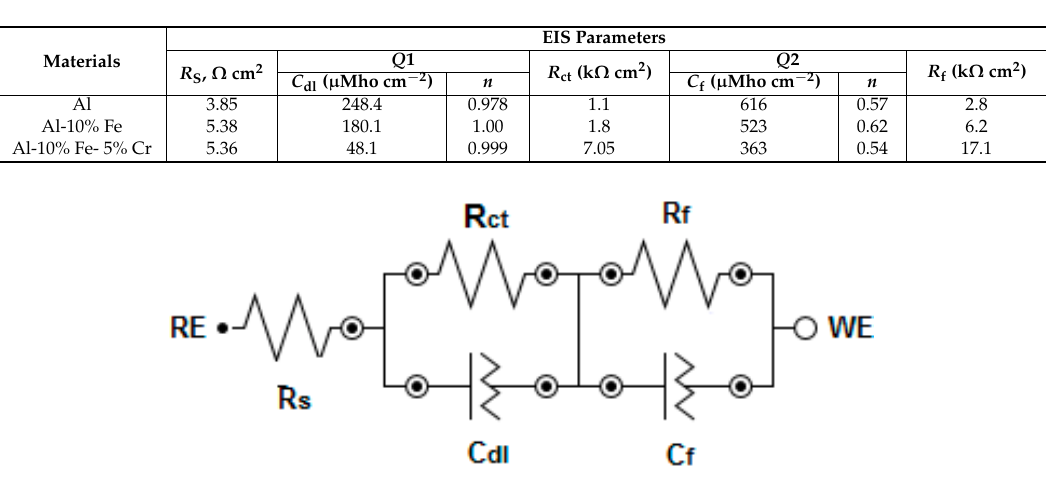
Figure 5. Nyquist plot of pure Al, Al ‐ 10% Fe and Al ‐ 10% Fe ‐ 5% Cr alloy immersed in 3.5% NaCl after 1 h at room temperature. Table 2 . Electrochemical Impedance parameters for pure Al, Al ‐ 10% Fe and Al ‐ 10% Fe ‐ 5% Cr alloy immersed in 3.5% NaCl after 1 h at room temperature.